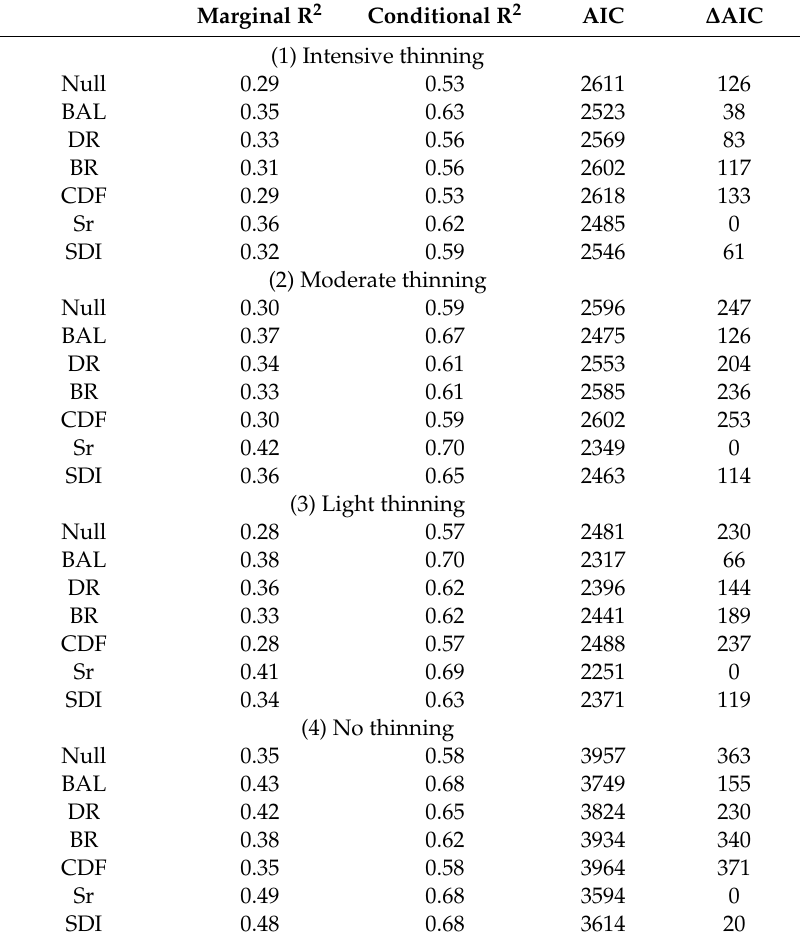
Table 3. Evaluation of thinning intensity-dependent multiple (TDM) models using each distance-independent competition